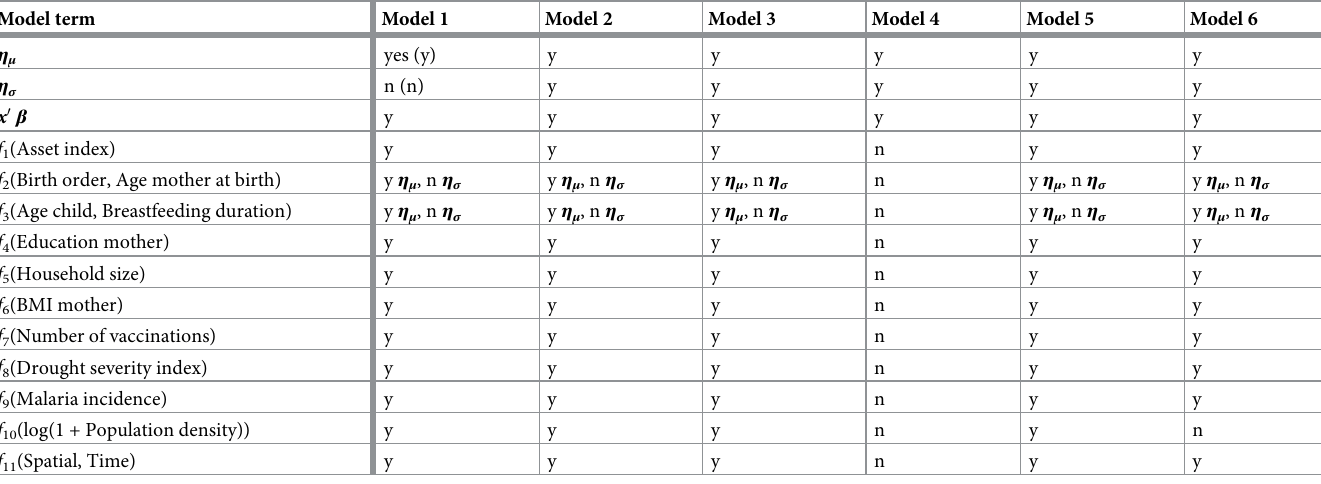
Table 4. Specification of estimated models.